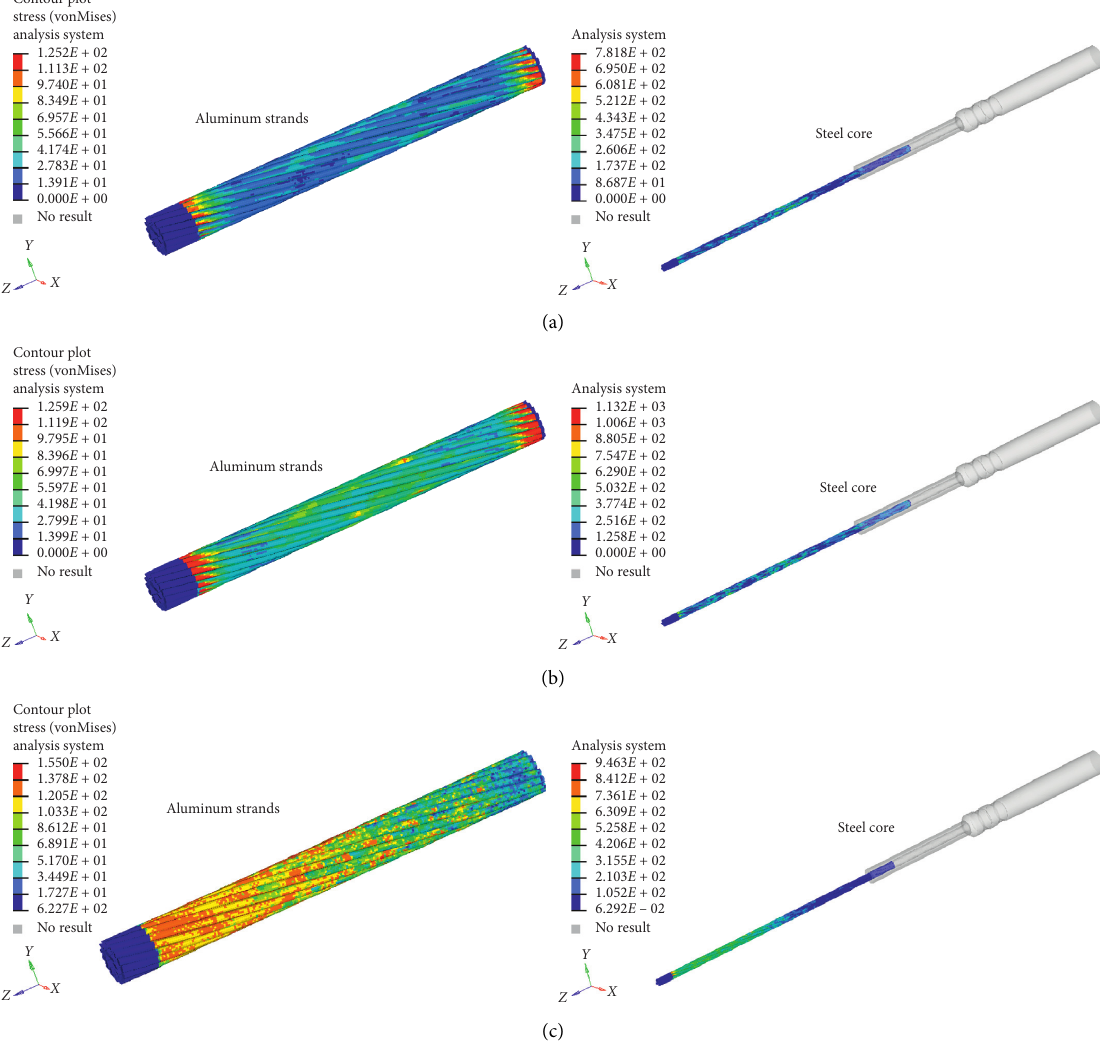
Figure 20: Stress in the aluminum strand and steel core under different tensile loadings: (a) 25% RTS; (b) 50% RTS; (c) ultimate load.